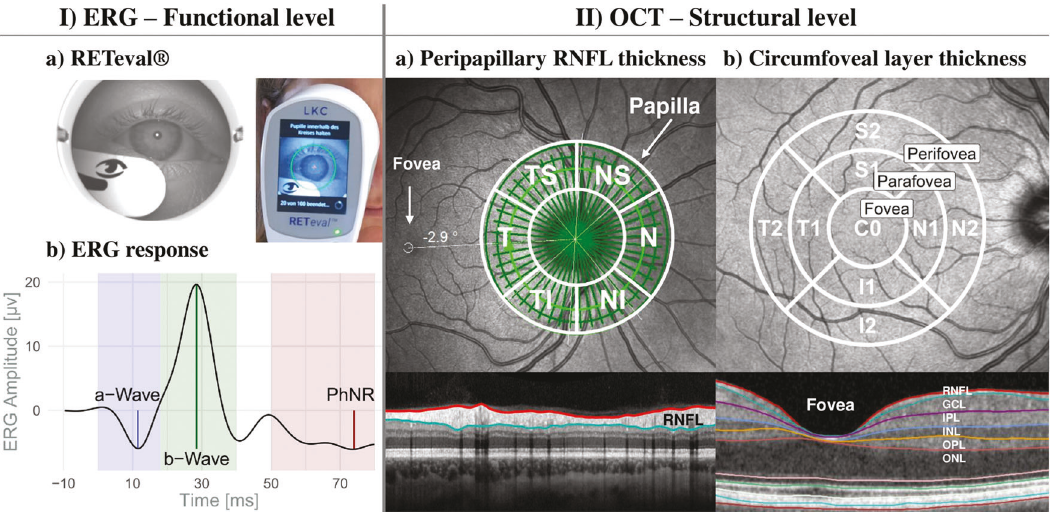
Fig. 1 Schematic overview of retinal examinations. ( I ) ERG: a ) Illustration of the RETeval ® system during recording (right) and a picture from the device internal camera (left); b ) Schematic retinal response comprising the a- and b-wave and the PhNR. ( II ) OCT: a ) Peripapillary RNFL thickness from the circle scan with the Garway-Heath-grid; b ) Circumfoveal scan for layer (macular, RNFL, GCL, IPL, INL, OPL, and ONL) thicknesses and volumes and the ETDRS grid (3 regions: fovea, parafovea, and perifovea). GCL ganglion cell layer, I inferior, INL inner nuclear layer, IPL inner plexifom layer, N nasal, ONL outer nuclear layer, OPL outer plexiform layer, RNFL retinal nerve fi ber layer, S superior, T